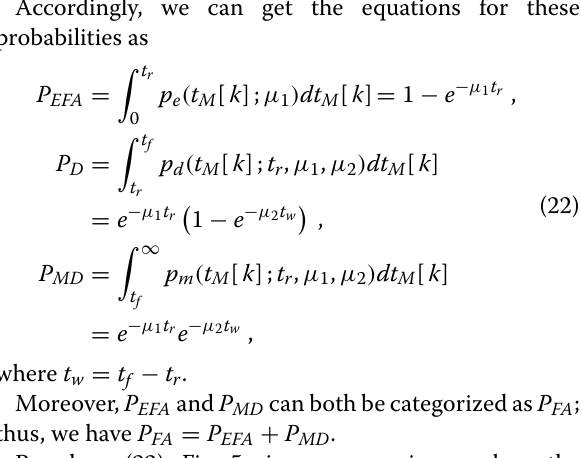
early false alarm ( P EFA ), probability of detection ( P D ), and probability of missed detection ( P MD ) as (cid:3) = { P EFA probability of a TOA measurement which occurs in the time interval before the FP pulse arrives}, (cid:3) = { P D probability of a TOA measurement which occurs in the time interval of the FP pulse}, (cid:3) = { P MD probability of a TOA measurement which occurs in the time interval after the FP